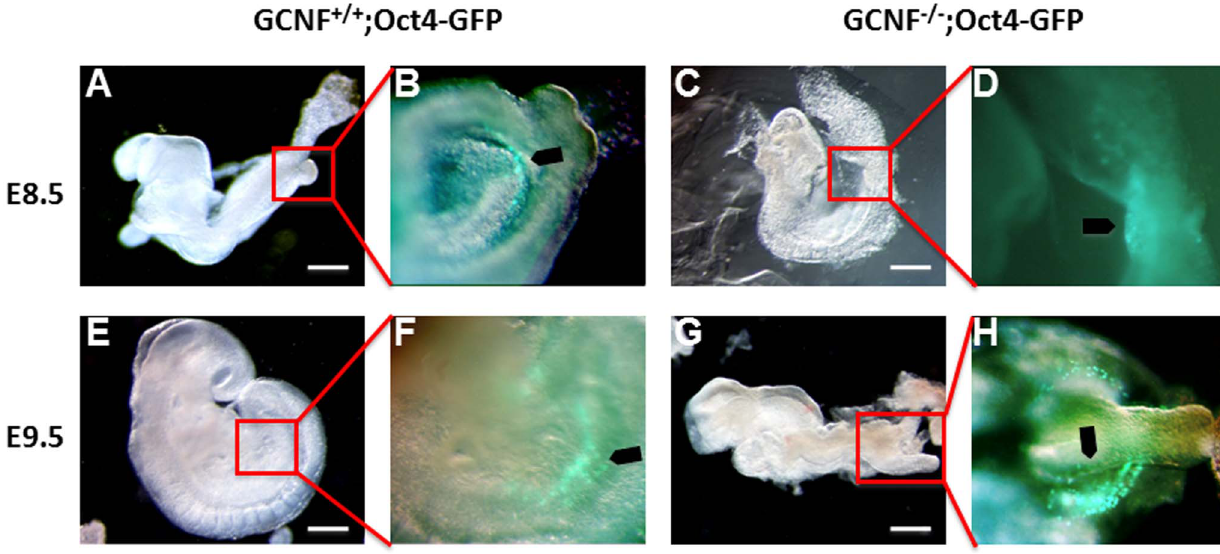
Figure 1. Detection of PGCs expressing green fluorescence from Oct4-GFP( D PE) in wt and Gcnf 2 / 2 embryos. ( A–B ) wt E8.5 embryos. ( C–D ) Gcnf 2 / 2 E8.5 embryos. ( E–F ) wt E9.5 embryos. ( G–H ) Gcnf 2 / 2 E9.5 embryos. Arrowheads indicate migratory PGCs. Note that the scale bars are 50 uM. Figures A, C, E and G are 25 6 and figures B, D, F, and H are 40 6 .